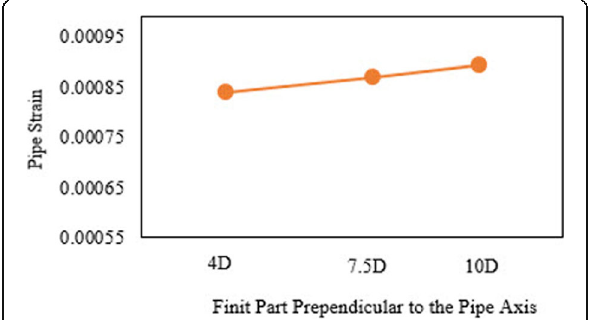
Fig. 5 Sensitivity analysis to determine optimal finite part of model perpendicular to pipe axis under Northridge earthquake ( SF = 0.7;